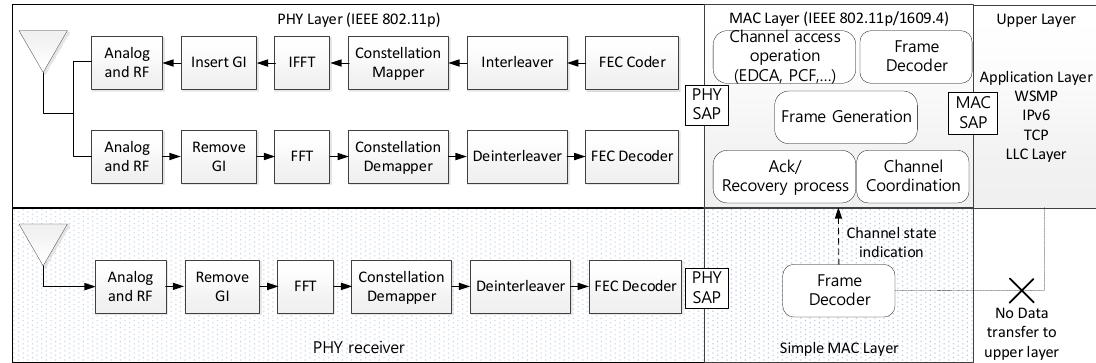
Figure 4. Proposed station architecture for 20-MHz channel access.